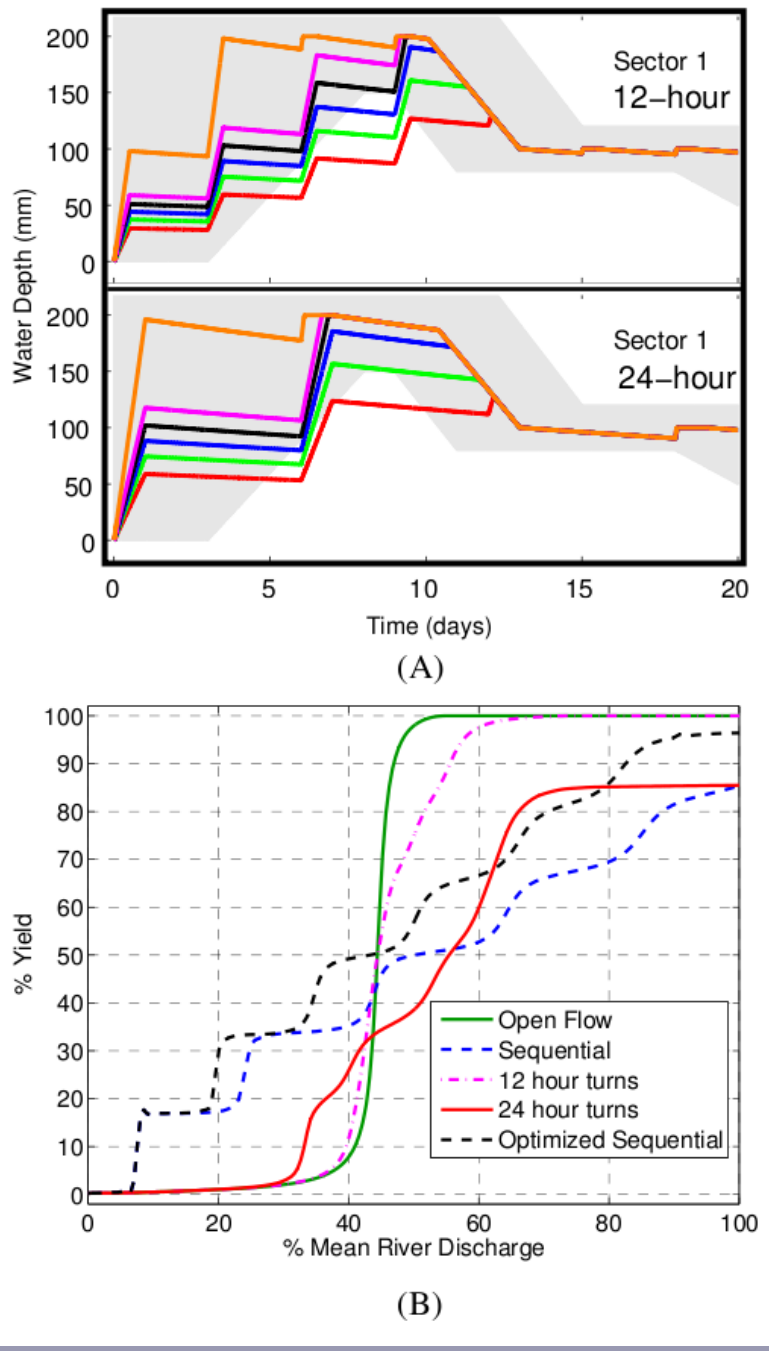
Fig. 8 . (A): Supply profiles for 12- and 24-hour rotation policies superimposed on desired flow level range (gray area) under changes in mean river discharge volume. (B): Total yield as a function of percentage mean river discharge for each of the five irrigation